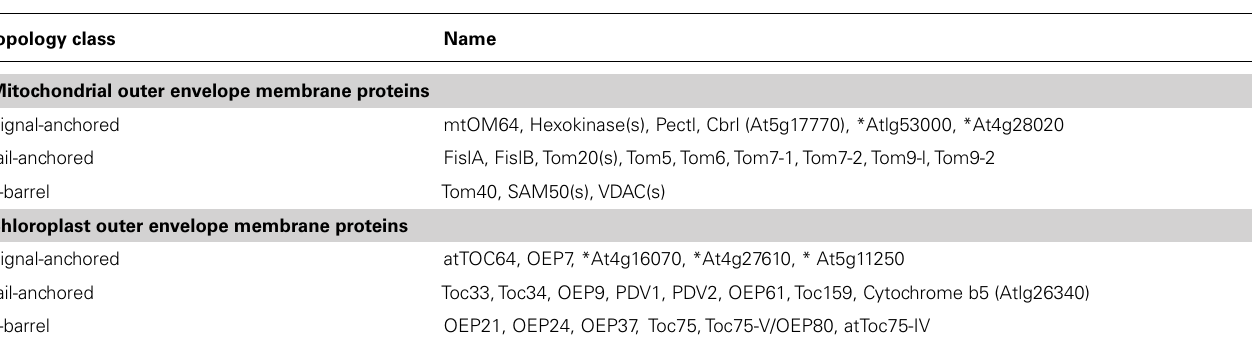
Table 1 | Arabidopsis proteins in the outer membranes of chloroplasts and mitochondria. Topology